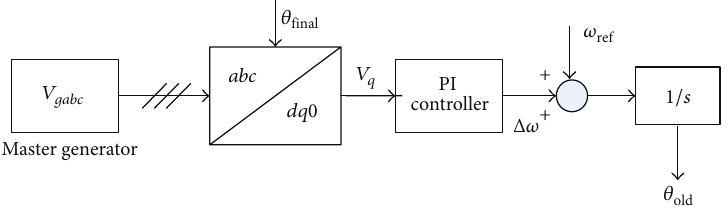
Figure 3: Synchronizing scheme using DQ algorithm.